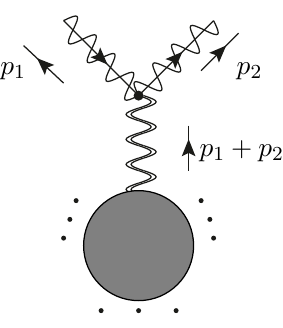
Figure 18 . Feynman diagrams leading to collinear gravitini singularities.